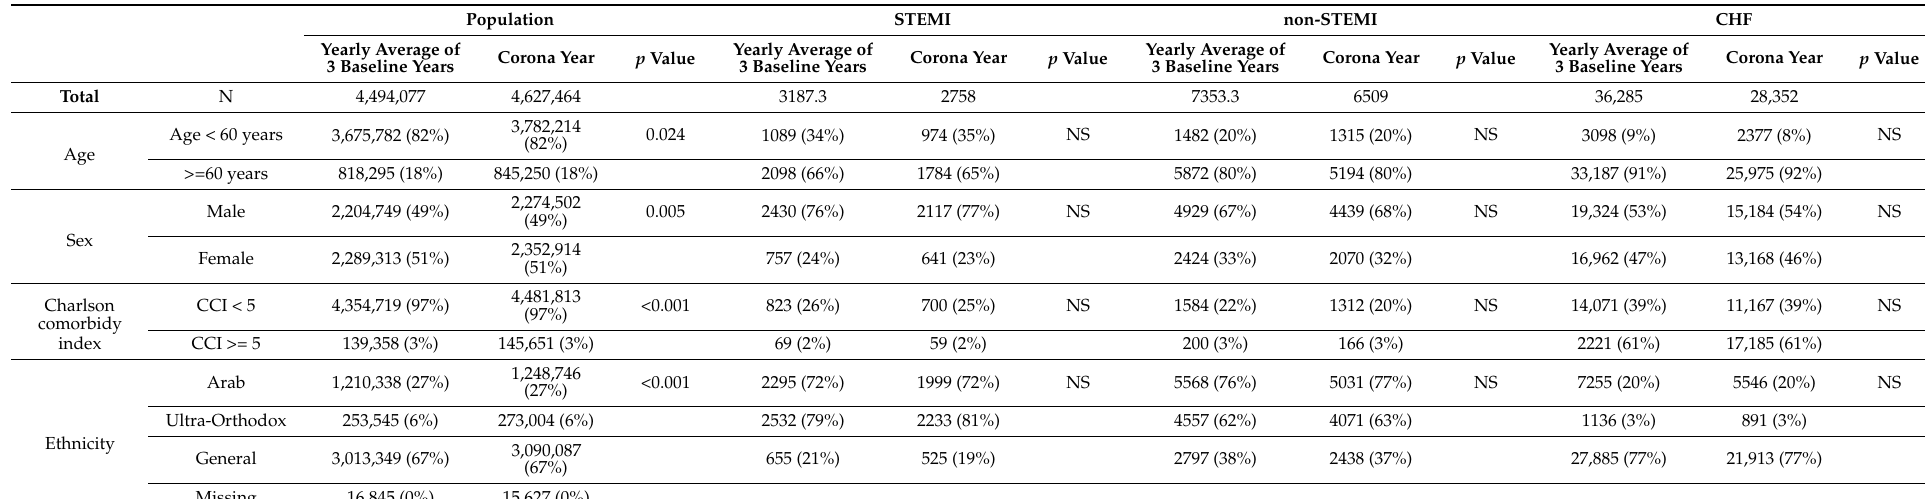
Table 1. Population and patient characteristics, Corona year and average of three baseline years.